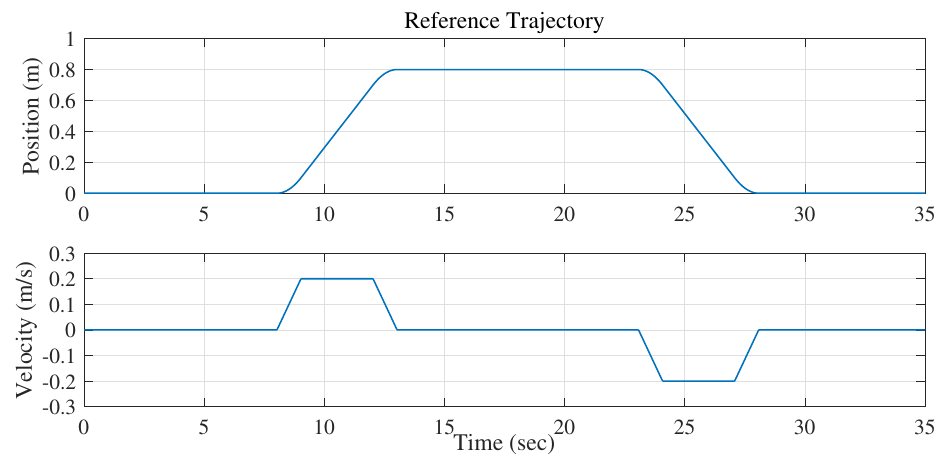
Figure 5. Reference trajectory used in simulation.